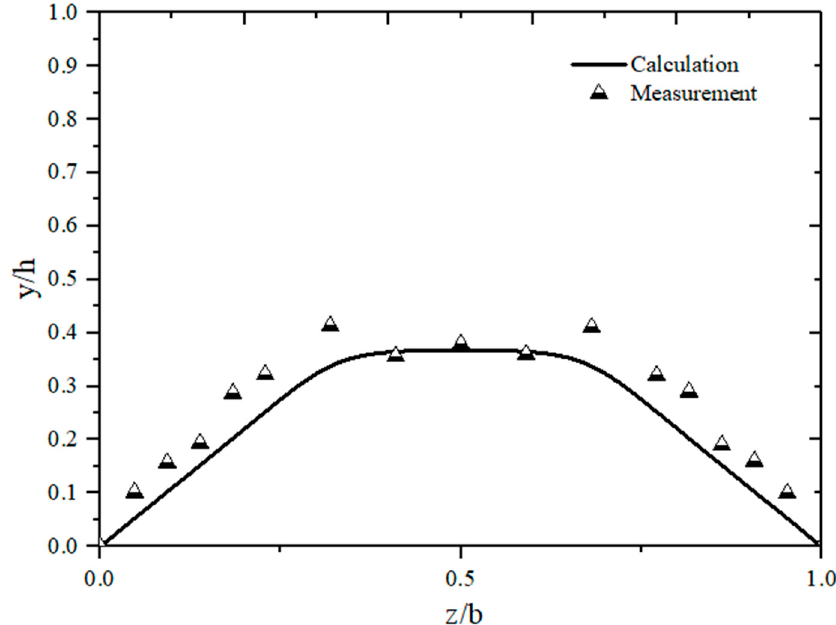
Figure 8. Comparison of the location of depth average velocity between the calculated and measured values along different vertical lines from the bedform to the water surface ( b / h = 3.297).